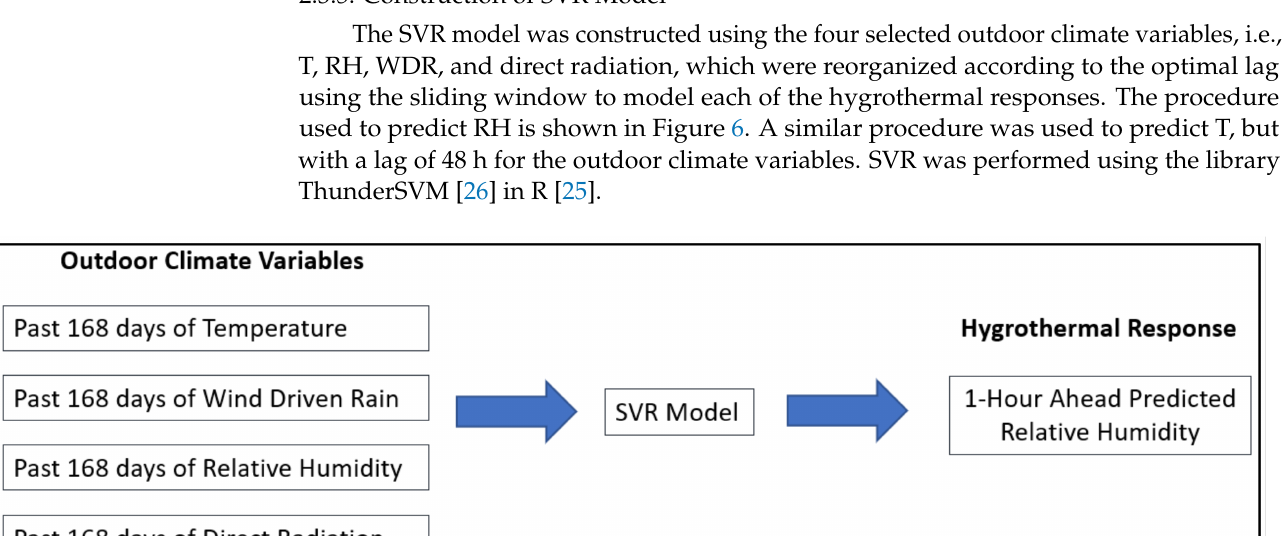
Figure 5. Contribution of the climate variables for the past 7 days to explain the variation in relative humidity at the exterior surface of OSB.